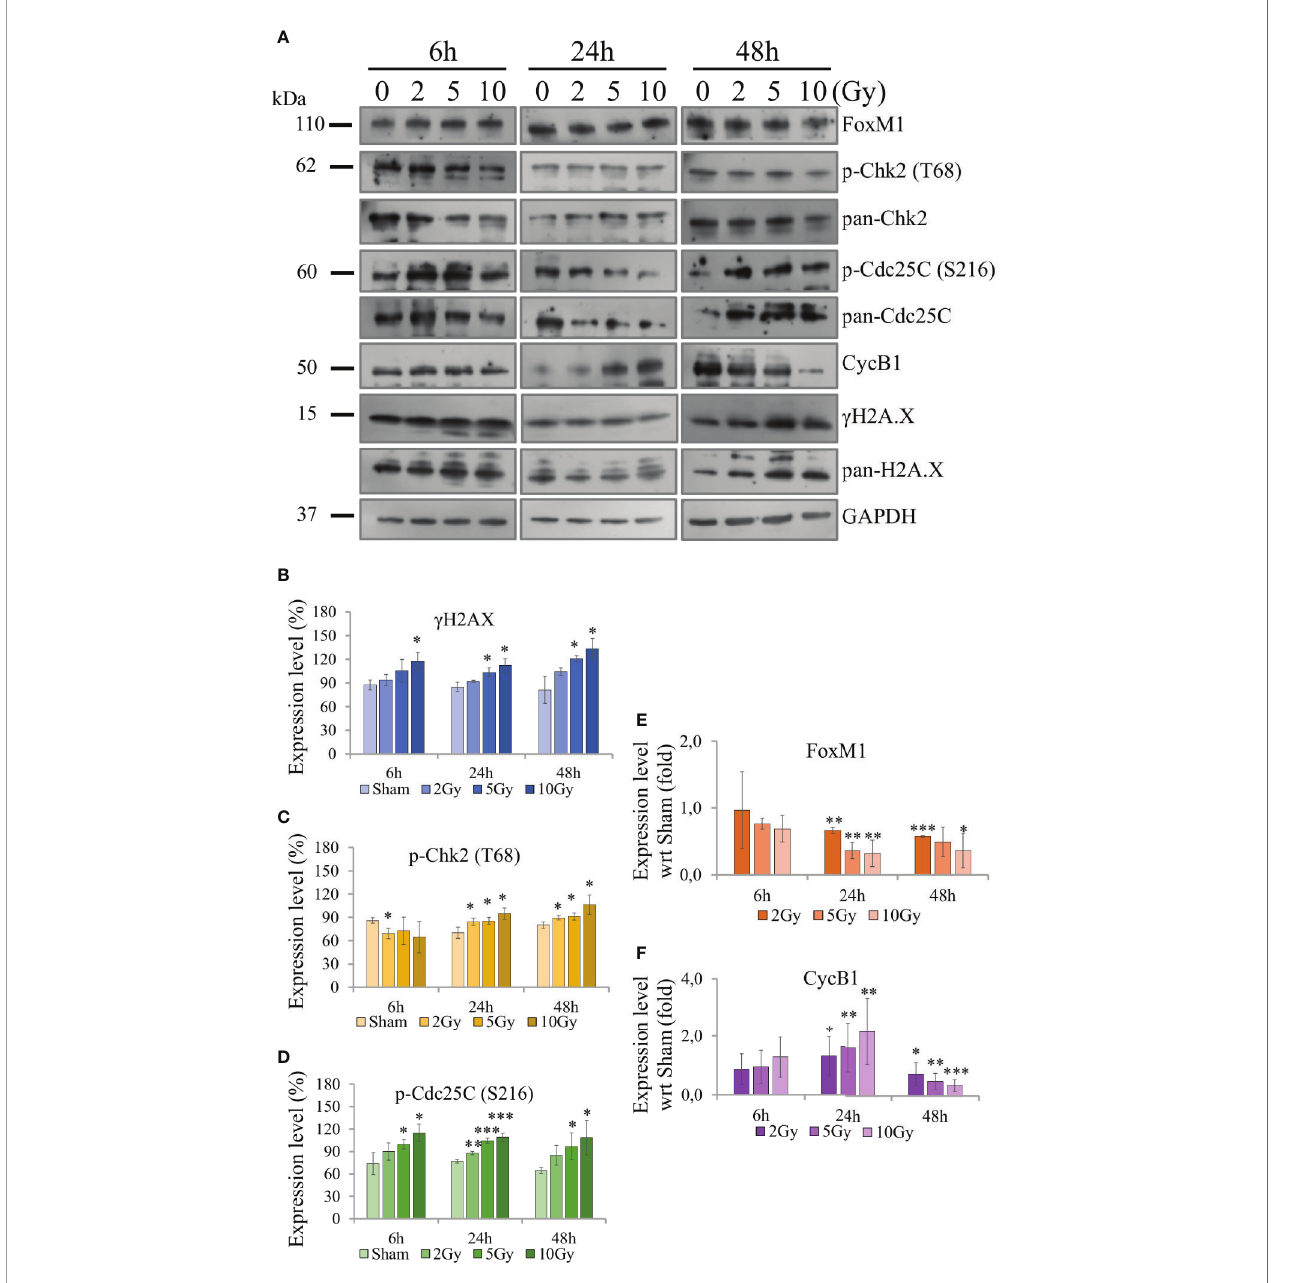
FIGURE 9 | Activity of proteins involved in DNA damage and cell cycle regulation with Western blot analysis. For Caco-2 cells following the “ Seed + Treat ” protocol: (A) Illustrative images of fi lms with expression patterns of all measured proteins at the different time points and irradiation conditions. Selected proteins are quanti fi ed and expressed as a function of time for the different irradiation conditions as follows: (B) ratio g -H2AX (S139) to total H2AX; (C) ratio phospho-Chk2 (T68) to total Chk2; (D) ratio phospho-Cdc25C (S216) to total Cdc25C; (E) ratio FoxM1 to the GAPDH loading control, normalized to the same ratio for the sham condition at the same time point; (F) ratio CycB1 to the GAPDH loading control, normalized to the same ratio for the sham condition at the same time point. Data reported are mean ± SD, obtained from ≥ 3 independent experiments. Statistical signi fi cance (Student ’ s t-test) is as follows: *p < 0.05, **p < 0.01, ***p <